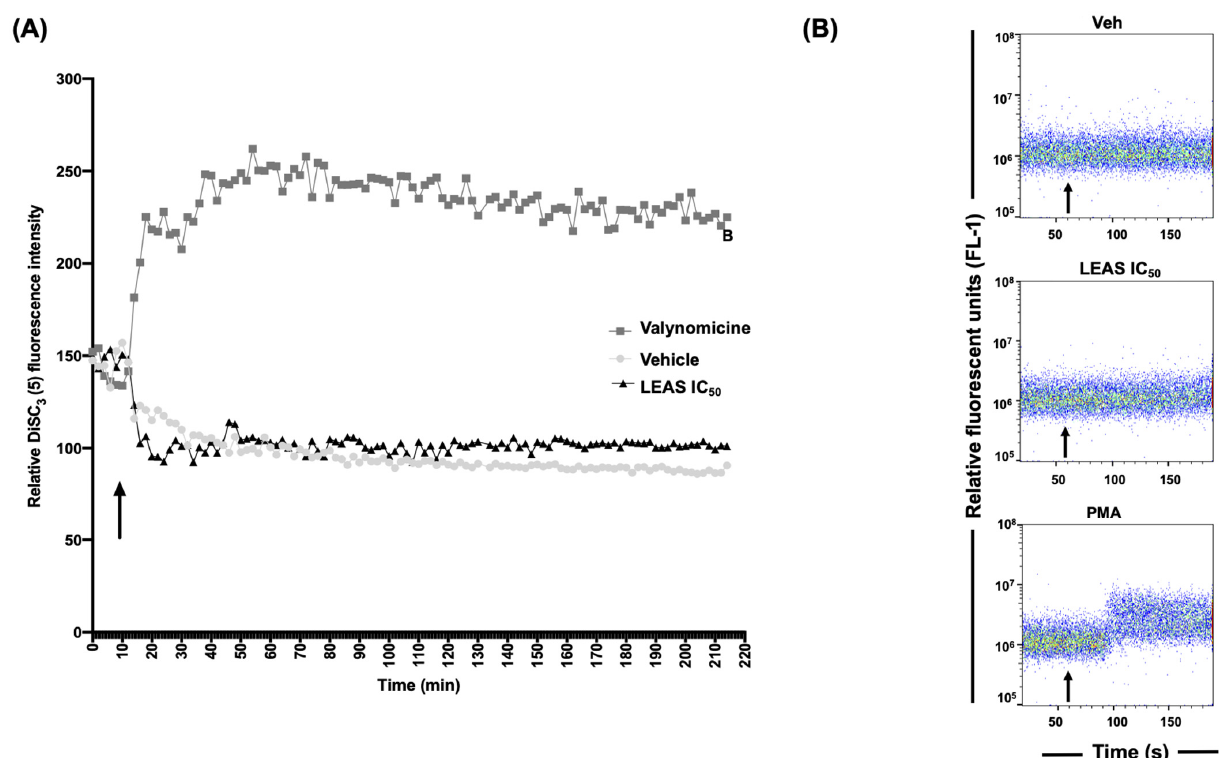
Figure 2. LEAS does not affect the cytoplasmic membrane integrity in D-17 cells. ( A ) Changes in the cytoplasmic membrane potential of D-17 cells were evaluated using membrane potential-sensitive dye. Cells were previously incubated with 200 µM of the dye DiSC3(5) for 30 min at 37 °C and then treated with LEAS IC 50 (15.5 µg/mL). Valinomycin (0.2 mM) was used as a positive control. ( B ) The efflux of cytosolic calcium was analyzed by flow cytometry. Measurements were assayed by 3 min, and at minute one the cells were treated with LEAS IC 50 (15.5 µg/mL), vehicle, or PMA 3 µM (acetate phorbol myristate) as a positive control. Representative plots are shown. Arrows indicate the time at which the treatments were added. Vehicle = DMSO (0.1%).